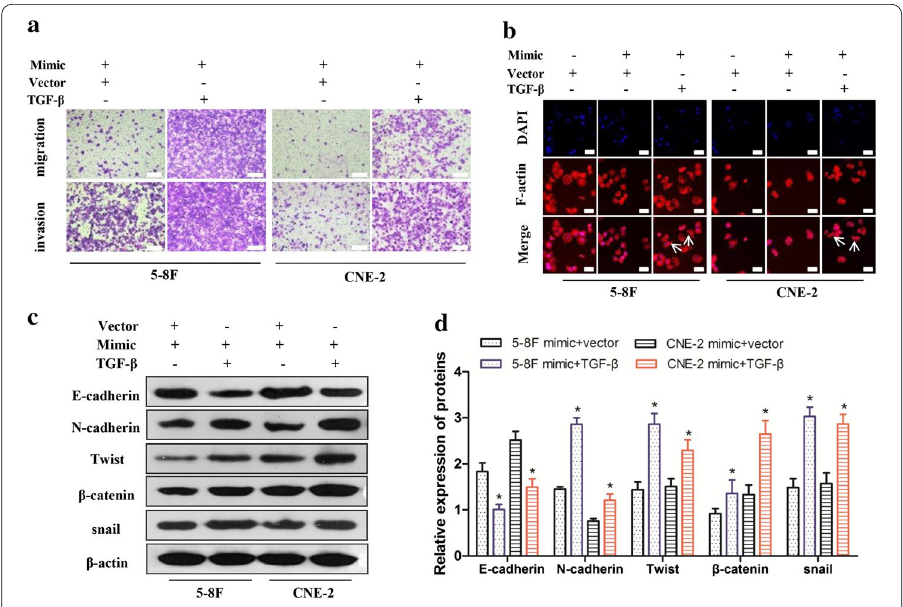
Fig. 5 TGF-β overexpression rescues the miR-296-5p-induced inhibition of tumor metastasis in NPC cells via EMT. a Transwell assays showed that exogenous TGF-β rescued the miR-296-5p-induced inhibition of metastasis in NPC cells. Scale bar 100 µm. b Immunofluorescence showed exogenous TGF-β rescued the miR-296-5p-induced transition to epithelial-like cells. Scale bar 100 µm. c Western blotting confirmed exogenous TGF-β rescued the expression of the EMT-related proteins in NPC cells. d The relative expression levels of the EMT-related marker gene proteins with gray-scale analysis. *p <